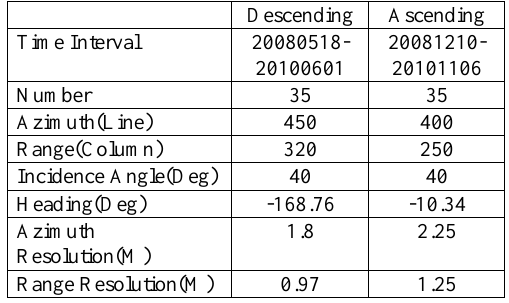
Cosmo-SkyMed SAR images